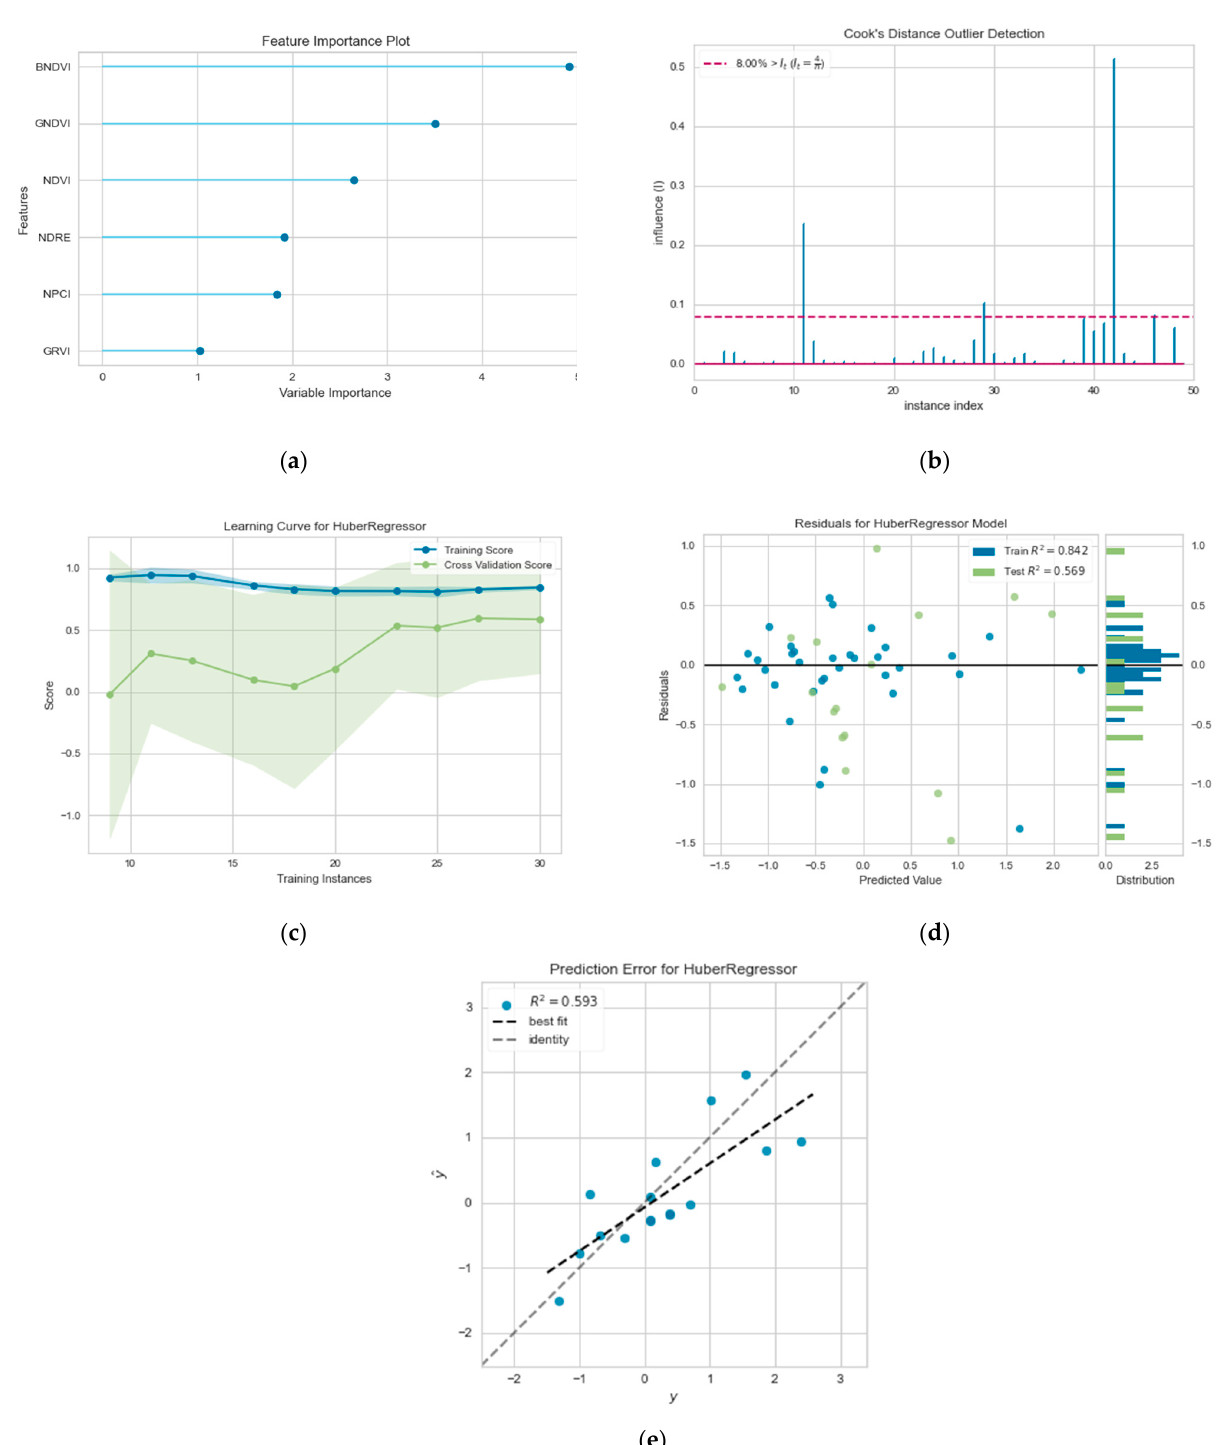
Figure 7. Huber regression model based on GTD and satellite remote sensing. ( a ) Feature or variable importance (independent variables) using the model, ( b ) Cook distance for outlier detection, ( c ) learning curve plot, ( d ) residual plot in the first fold as training and testing, ( e ) prediction error scatterplot with testing data identifying y as the observed values and ŷ as the predicted values. Applying tuning to the model, the hyperparameters defined were slightly changed as 𝛼 = 0.005 , 𝜖 = 1.2 . By applying the parameters, the tuning increased the R 2 value of